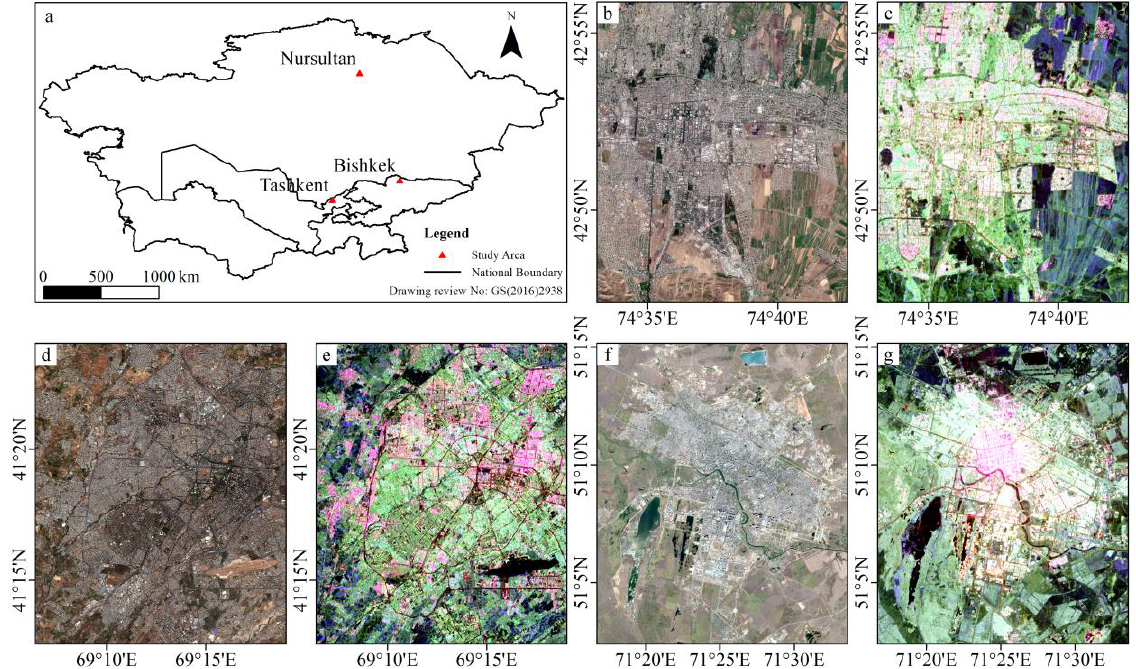
Figure 1. Locations and satellite images of the study areas. ( a ) Location of the study cites. ( b ) Sentinel-2 RGB image of Bishkek. ( c ) GF-3 Pauli-RGB image of Bishkek. ( d ) Sentinel-2 RGB image of Tashkent. ( e ) GF-3 Pauli-RGB image of Tashkent. ( f ) Sentinel-2 RGB image of Nursultan. ( g ) GF-3 Pauli-RGB image of Nursultan. Table 1. Sentinel-2 and GF-3 data for the study areas used for ISA extraction. Study